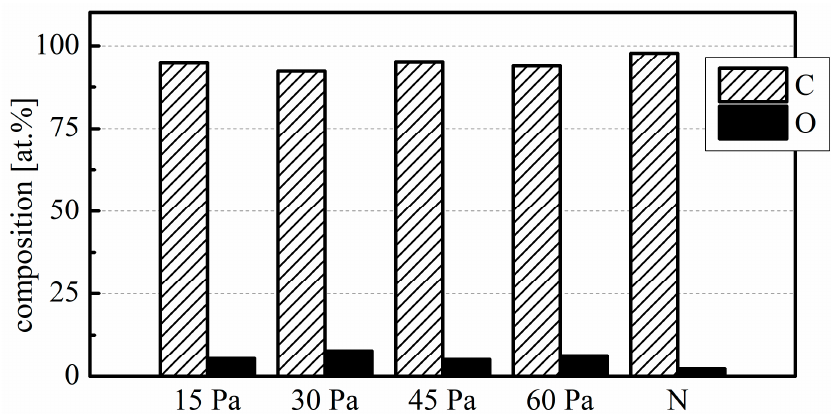
Figure 2. Elemental composition of the garlic clove surface. 15 Pa, 30 Pa, 45 Pa, 60 Pa: plasma treatments at the indicated working pressure; N: untreated control.